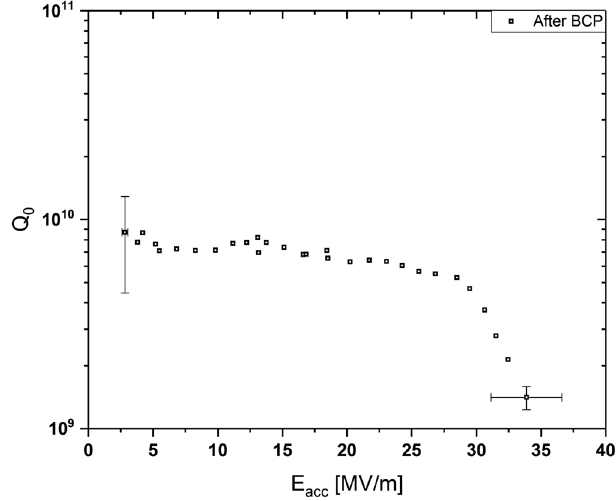
FIG. 7. FH3F test results at T b ¼ 2 . 0 K. Note the characteristic high-field